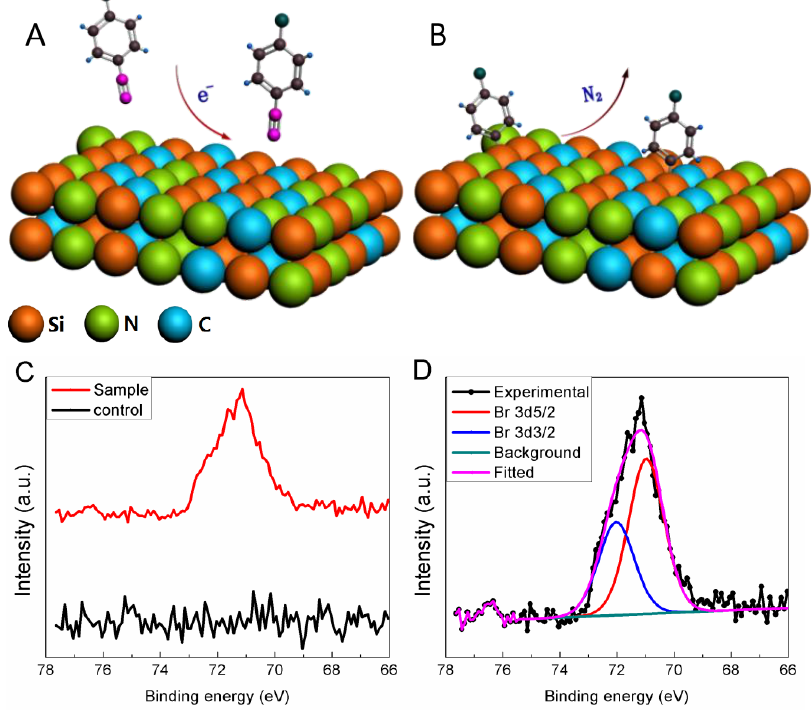
Figure 4. Reaction mechanism and XPS analysis of aryl diazonium modification of SiCN surface: ( A ) Aryl diazonium salt reduction by electrons; ( B ) the created free aryl radicals strongly bond to the SiCN surface; ( C ) XPS high resolution scans of Br element spectra on aryl diazonium modified SiCN sample and control surfaces; ( D ) XPS experimental bromine spectrum and theoretical Br 3d fitted